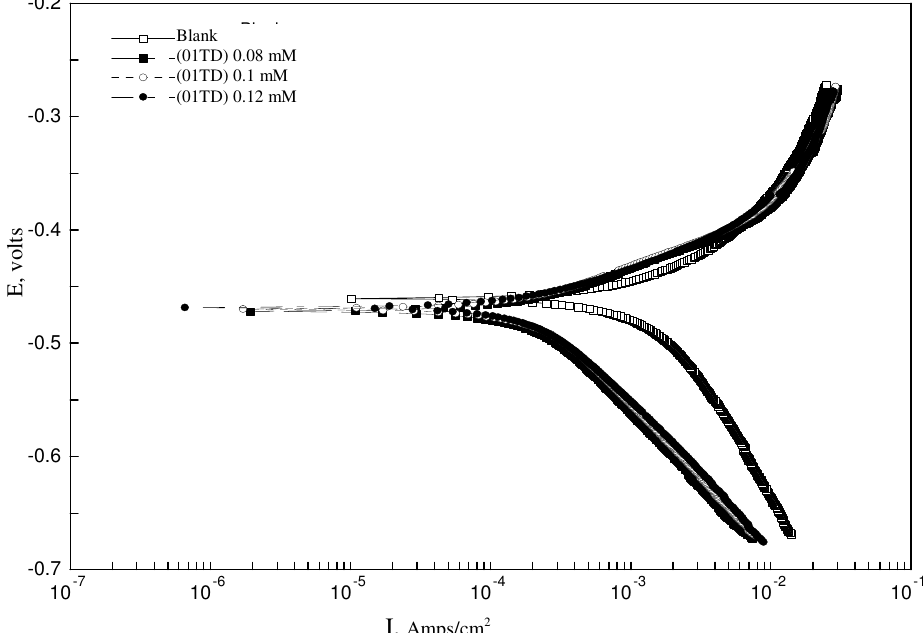
Figure 2. Potentiodyanamic Polarization curves for mild steel in 1 M H presence of